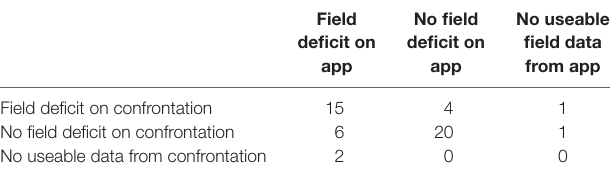
TaBlE 2 | Contingency table describing test positive and negative results for StrokeVision app versus standard confrontation (visual fields), third row and column describes where participants were untestable or did not complete testing.